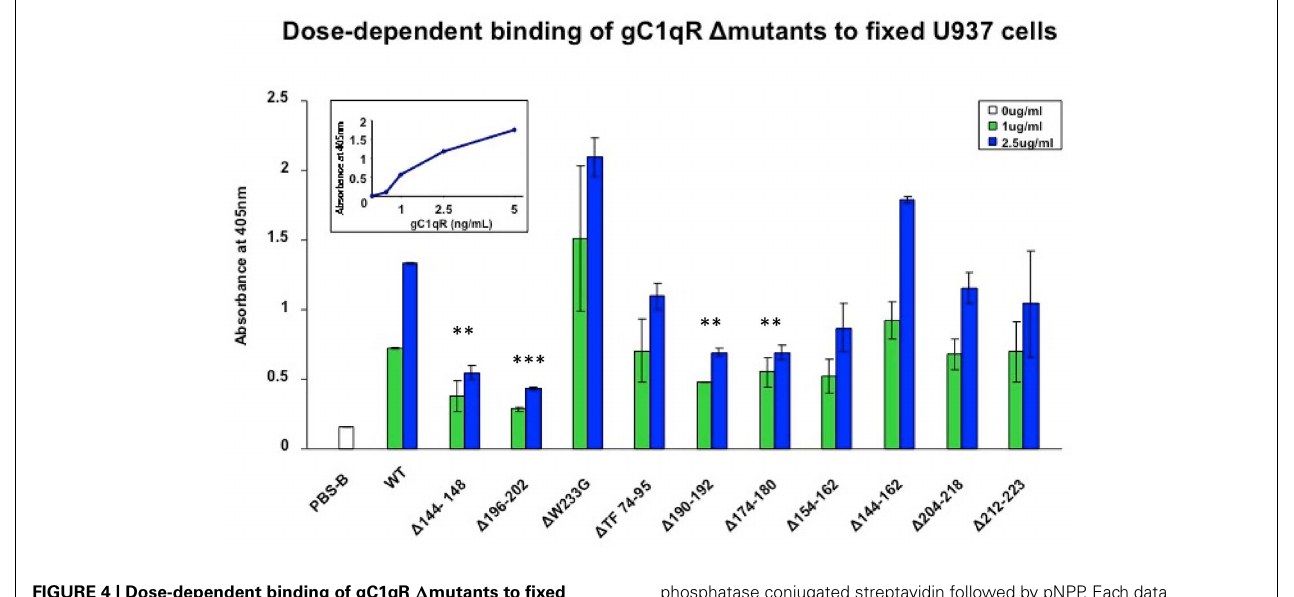
FIGURE 4 | Dose-dependent binding of gC1qR Δ mutants to fixed U937 cells. U937 cells were first attached to 96-well microtiter plates using poly-l-Lysine and fixed as described (Kennet, 1984; Ghebrehiwet et al., 1996).The cells were then reacted with biotinylated gC1qR wild type (WT) or gC1qR deletion mutants ( Δ ) mutants. After incubation, the plate was developed by sequential addition of alkaline